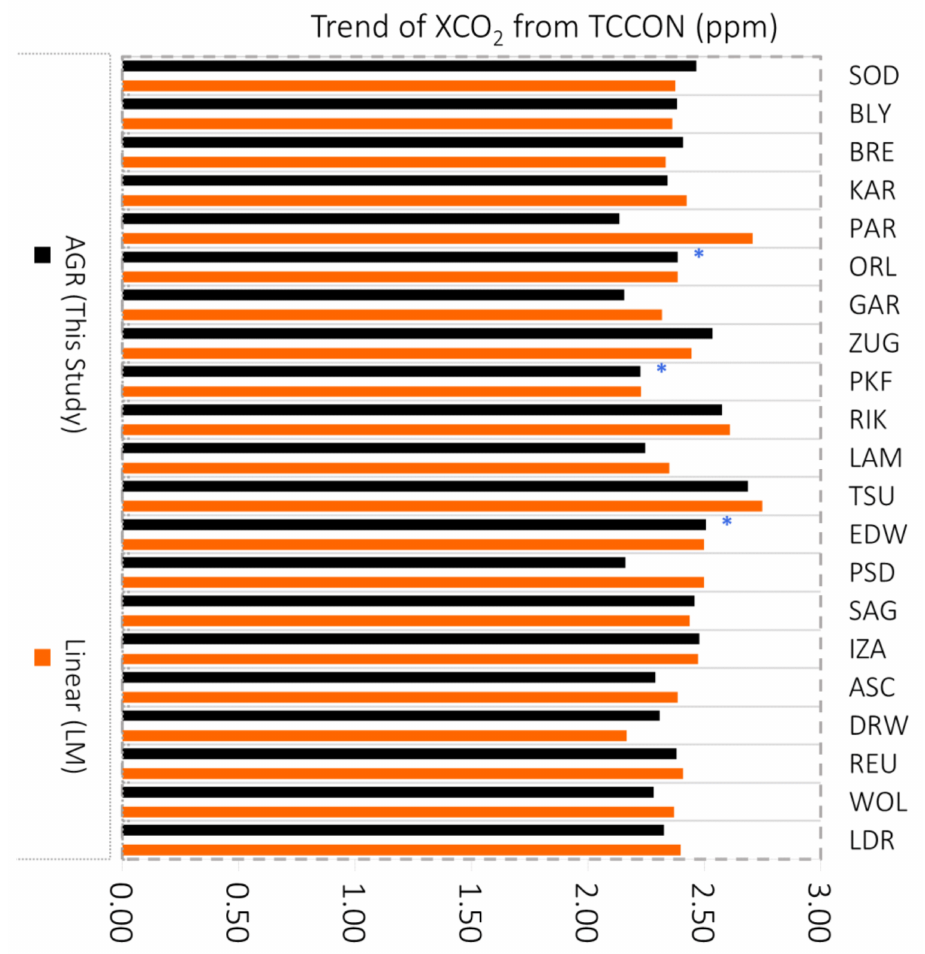
Figure 4. This study’s AGR TCCON (black) and [28] methodology or LM (orange) estimates. Asterisk labels indicate the existence of agreement between these estimates, according to the strict criterion of statistical agreement, driven by LM-based error estimates. EUR and NYA stations are not used in this analysis due to the lack of data for a simultaneous evaluation of the seasonal cycle according to LM. The stations are sorted from top to bottom of the plot using the station